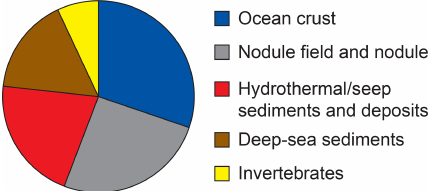
Figure 5. Habitat coverage for the most closely related sequences ( ≥ 99% similarity) to OTUs highly abundant in the nodules. For details see Table